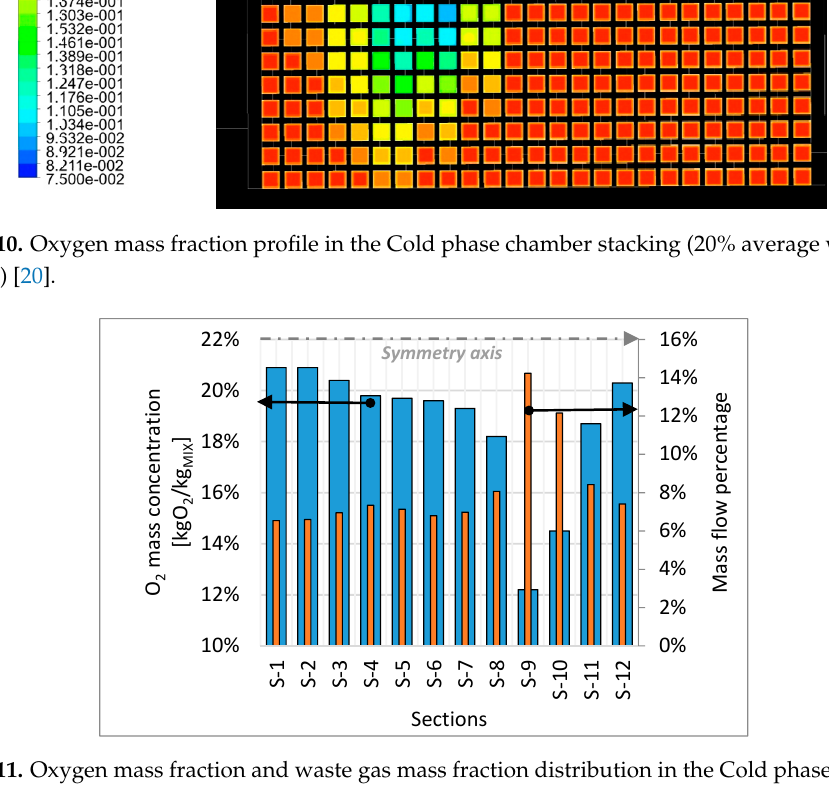
Figure 11. Oxygen mass fraction and waste gas mass fraction distribution in the Cold phase chamber stacking (20% average waste gas fraction) [20].